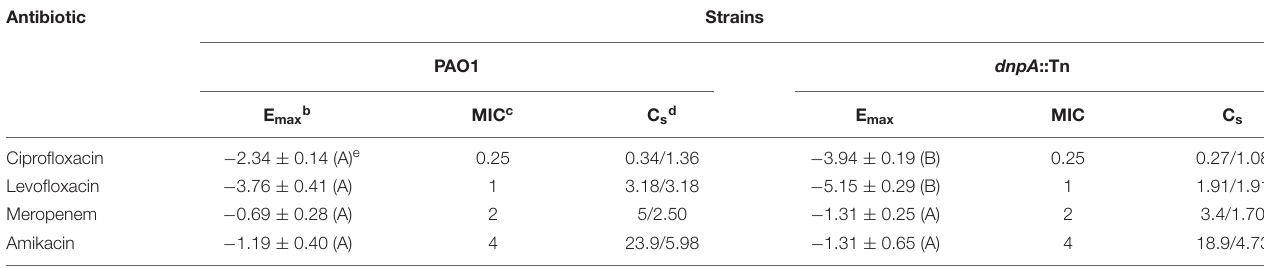
TABLE 3 | Pertinent regression parameters of concentration-response curves for intraphagocytic activities of antibiotics against P. aeruginosa strains a . Antibiotic Strains PAO1 dnpA ::Tn E maxb MIC